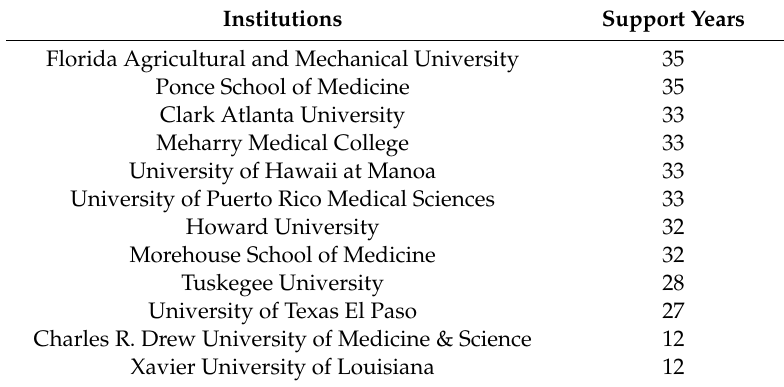
Table A1. Active research centers in minority institutions (NIH RePORTER, May 2020 1